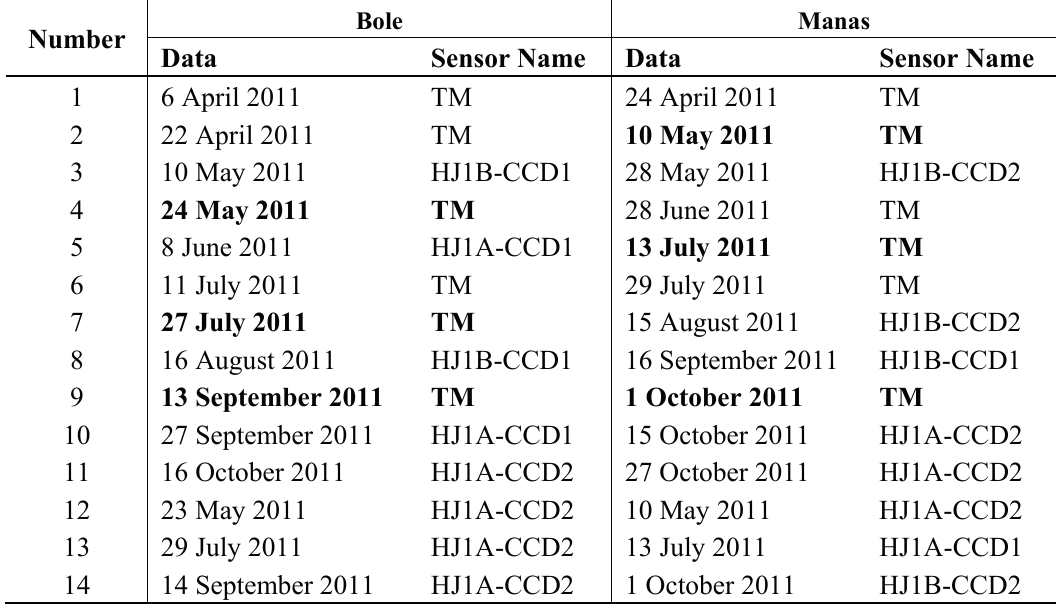
Table 2. Landsat-5 TM and HJ-1 CCD images for both study